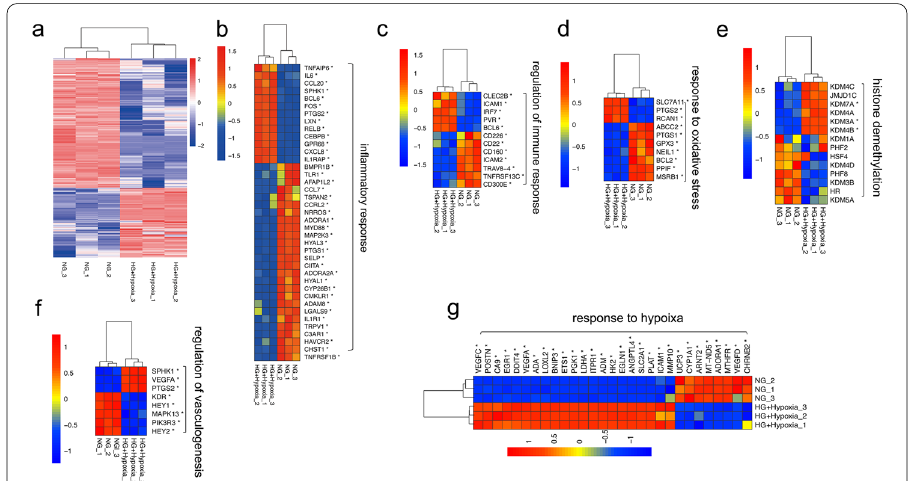
Fig. 6 Heatmaps of HUVECs induced by high glucose and hypoxia exposure by RNA-sEq. a Heatmaps of differentially expressed genes related to the inflammatory response ( b ), regulation of immune response ( c ), response to oxidative stress ( d ), histone demethylation ( e ), response to angiogenesis ( f ), response to hypoxia ( f ), and regulation of angiogenesis ( g